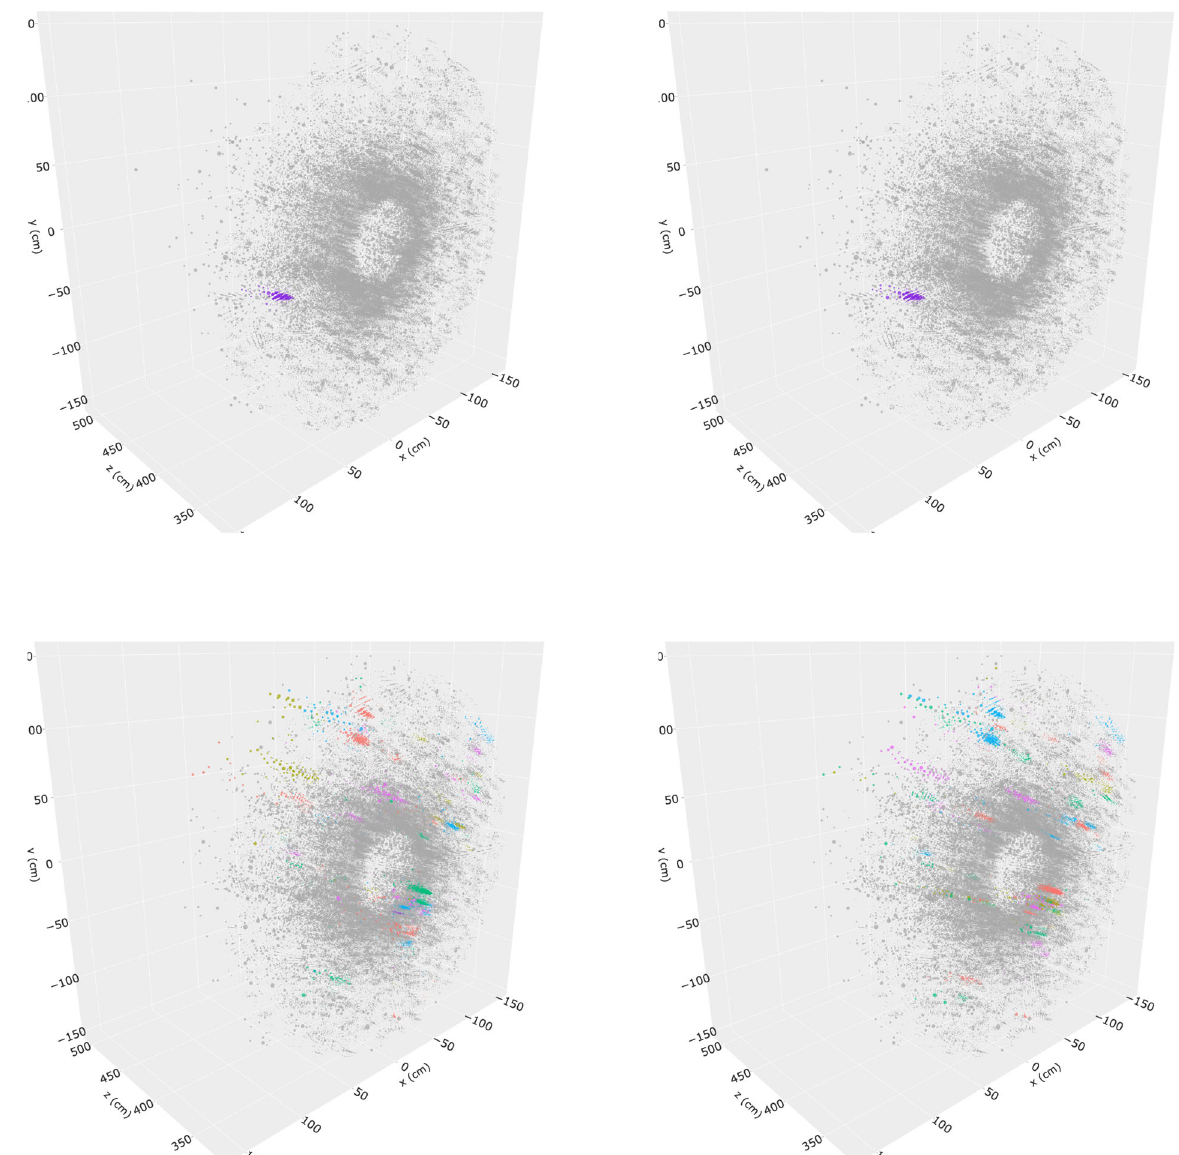
Fig. 9 True versus predicted cluster examples in 200 pileup. In the top two figures, a single particle is shot into the calorimeter, where the left andrightfiguresshowthetrueandthecorrespondingmatchedpredicted cluster, respectively. The bottom row shows particles originating from